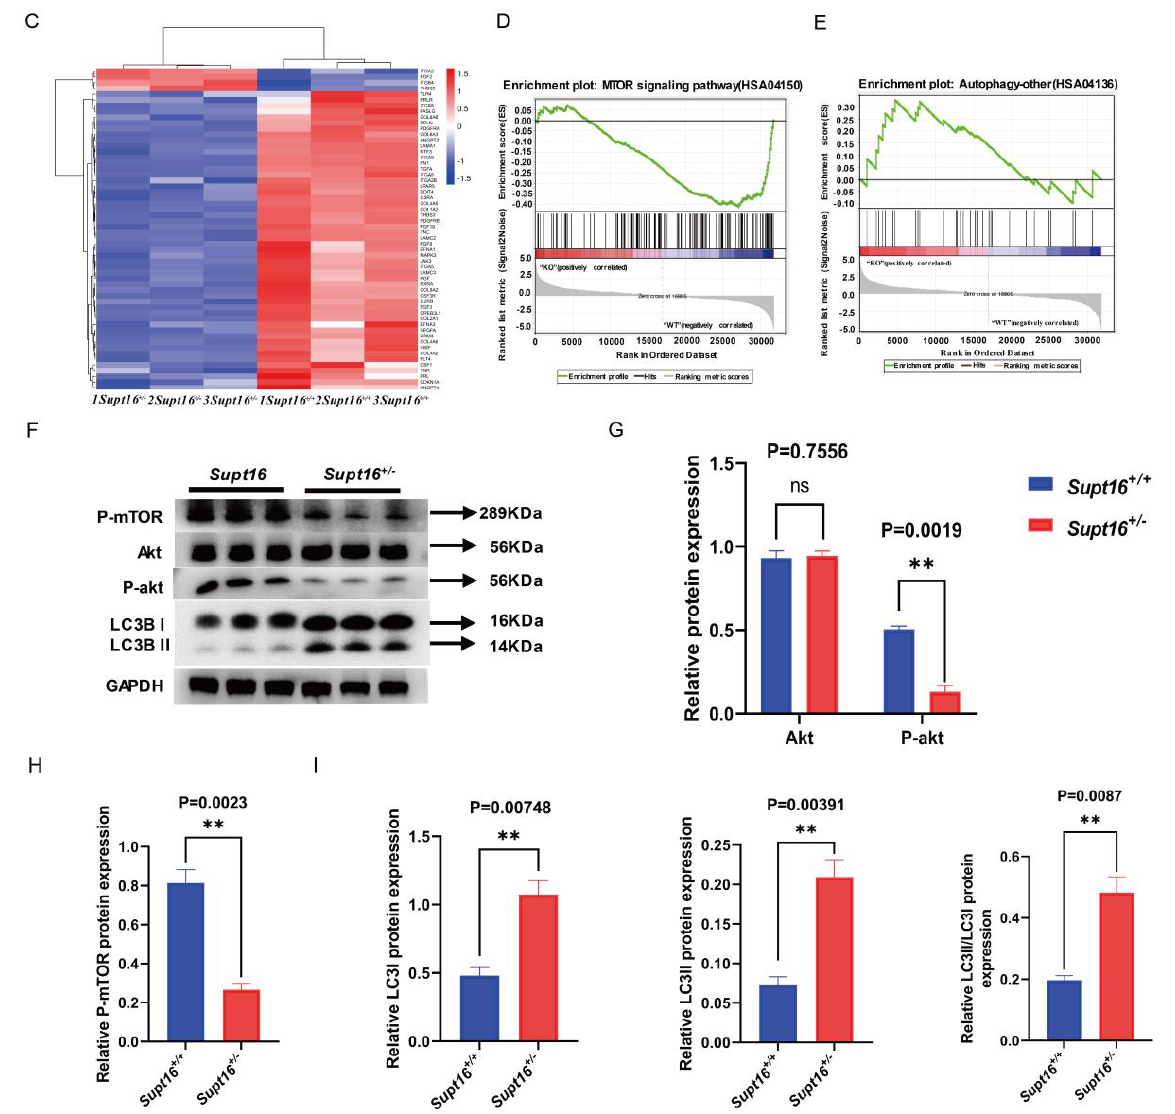
Figure 2. Supt16 haploinsufficiency impaired hNSC self − renewal by activating PI3K/AKT/mTOR − mediated autophagy. ( A ) Volcano plots showed all differential expression genes detected by DESeq2 in Supt16 heterozygous hNSCs. Each point represents an individual gene, of which 1629 genes are upregulated and 1976 genes are downregulated ( p − value < 0.05; |log2foldchange| > 1). n = 3. ( B ) KEGG pathway analysis found that differential expression genes in Supt16 +/ − hNSCs are enriched in the PI3K/AKT signaling pathway. ( C ) Heatmap analysis of PI3K/AKT signaling pathway − related differential expression genes enriched in KEGG analysis. ( D ) GSEA plot of differentially expressed genes for the list of mTOR signaling pathway genes (NES, normalized enrichment score; FDR, false discovery rate. NES = − 1.79, FDR = 0.055). ( E ) GSEA analysis showing the expression pattern of autophagy − related genes in WT and Supt16 +/− hNSCs (NES, normalized enrichment score; FDR, false discovery rate. NES = 1.358, FDR = 0.254). ( F ) Western blot analysis showing AKT, P − akt, P − mTOR, and LC3 expression in hNSCs treated with different treatments ( n = 3 samples per genotype). ( G ) Quan- tification analysis of AKT and P − akt protein relative to GAPDH. Data are means ± standard deviation of three independent experiments. ( H ) The P − mTOR expression was calculated relative to GAPDH. Data are means ± standard deviation of three independent experiments. ( I ) Quantification of LC3 protein relative to GAPDH. Data are means ± standard deviation of three independent experiments. The error bars represented the mean ± SD and the significance level was calculated by Student’s t-test (two-tailed, equal variance) (ns means not statistically significant, ** p <